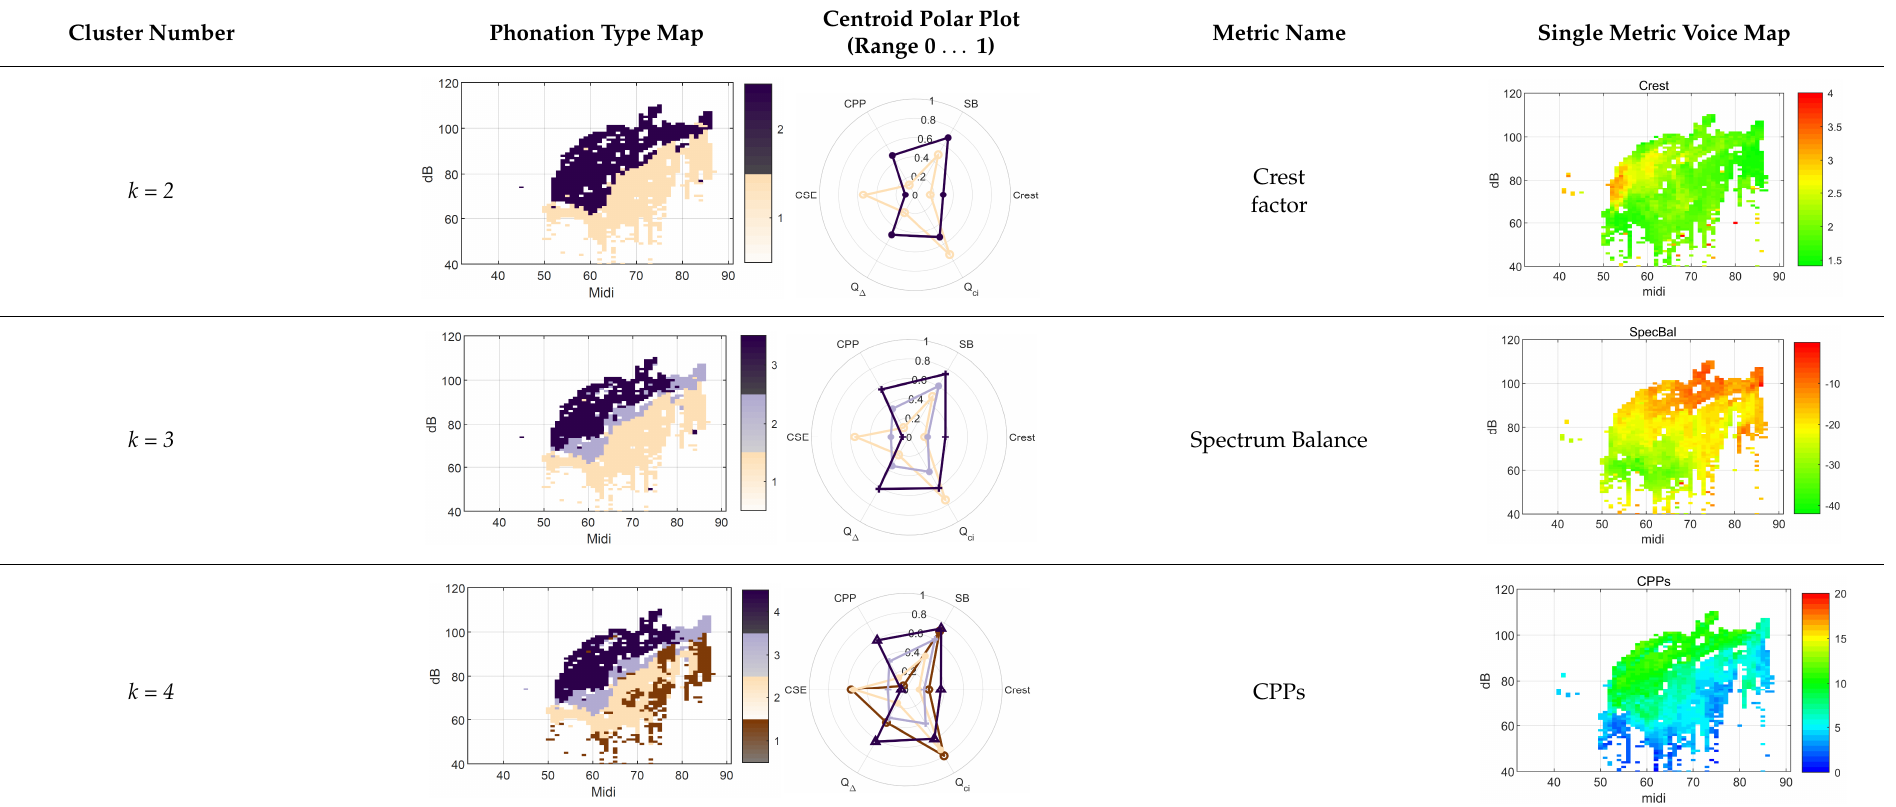
Table A2. Female participant F06.